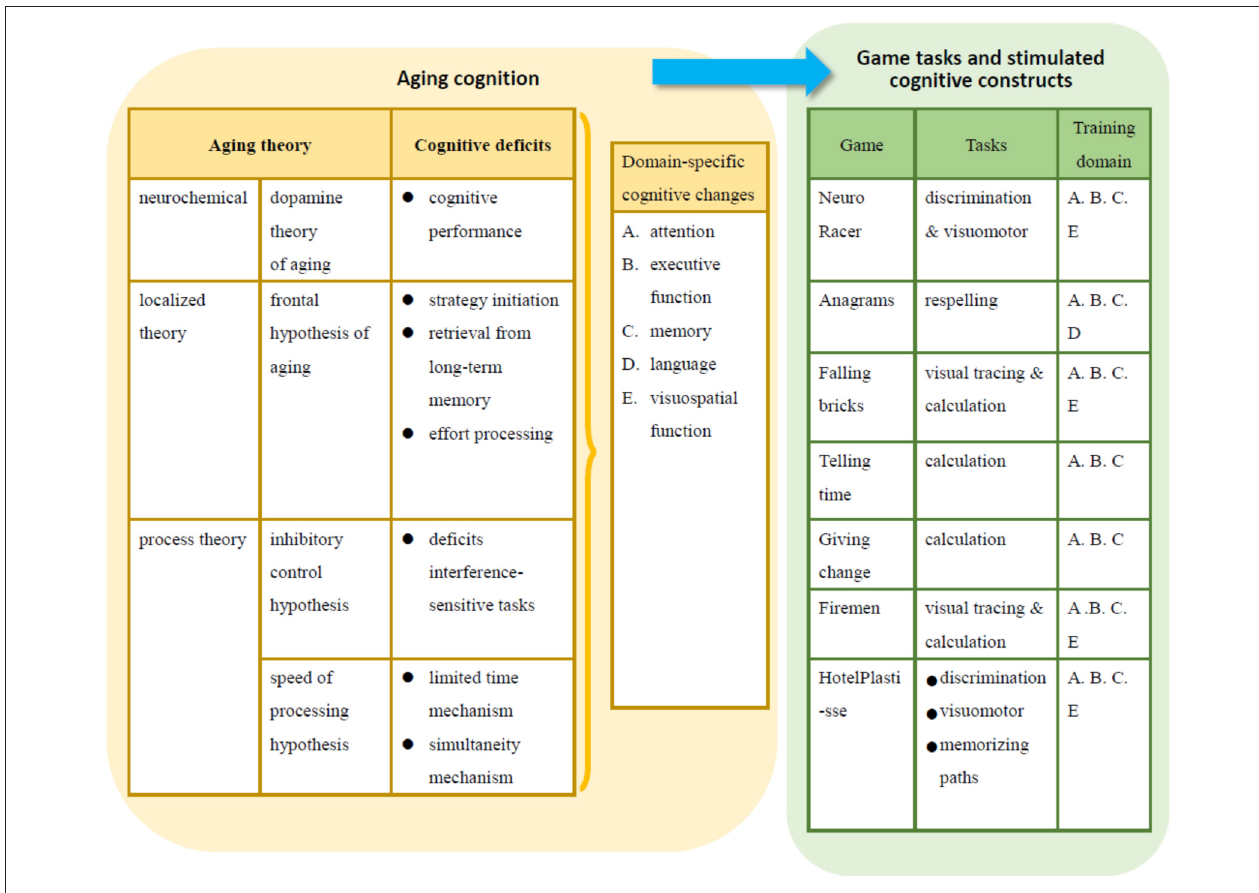
FIGURE 1 | Aging cognition and cognitive training structure of related